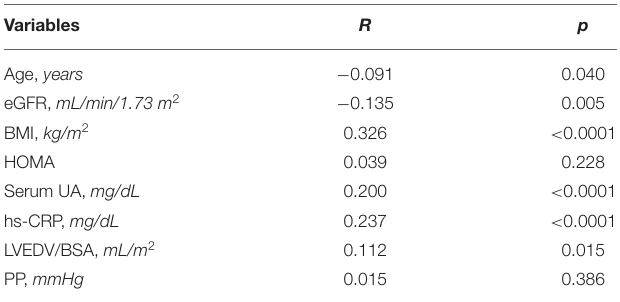
TABLE 4 | Linear regression analysis focused on AHI as dependent variable in SA patients. Variables